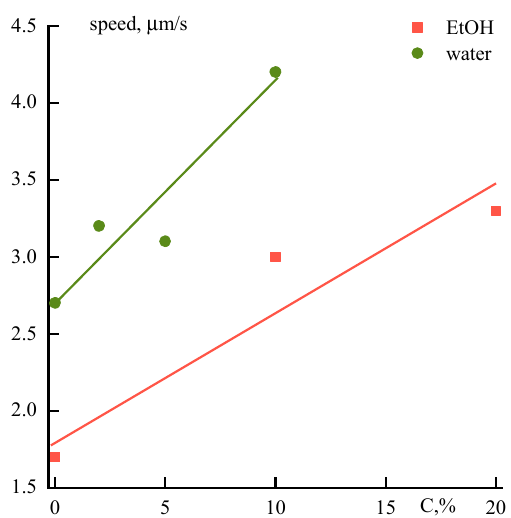
Figure 17. Dependence of the diffusion front rate into a drop of a solution containing alcohol or water on their content.